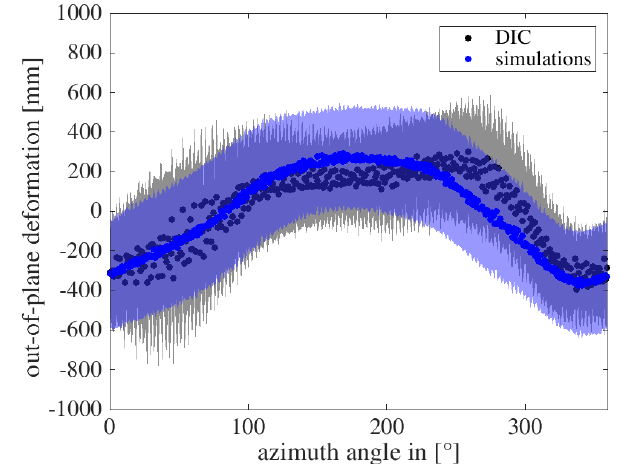
Figure 23. Measured wind turbine pitch angle and DIC pitch + tor- sion